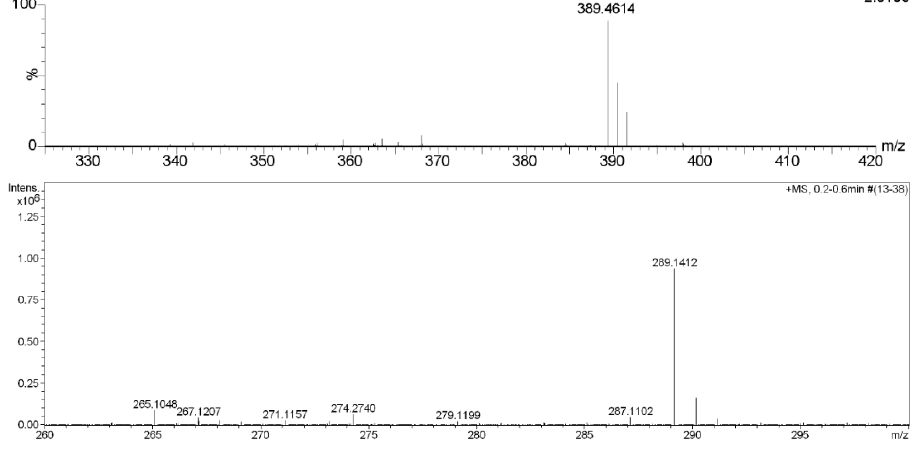
Figure 2. HR-ESI-MS spectra of compounds 1 (upper) and 11. Table 1. 1 H and 13 C NMR data of compounds 1 and 11 in CD 3 OD.